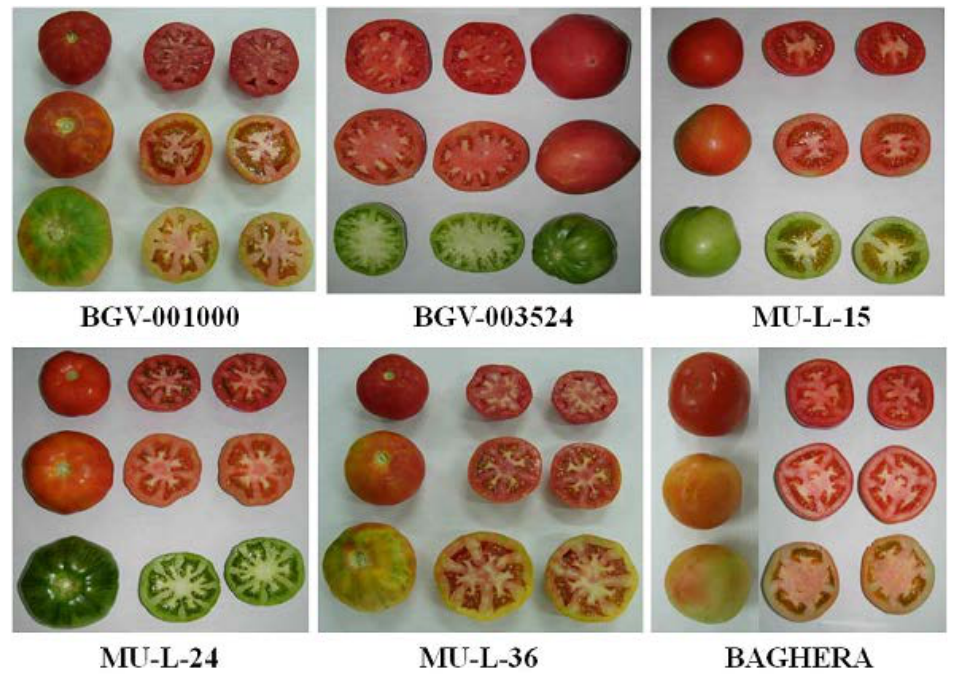
Figure 1. Traditional varieties and commercial hybrid: BGV001000 (T1), BGV003524 (T2), MUL15 (T3), MUL24 (T4), MUL36 (T5) and ‘Baghera’ F1 (T3), MUL24 (T4), MUL36 (T5) and ‘Baghera’ F1 (Baghera).